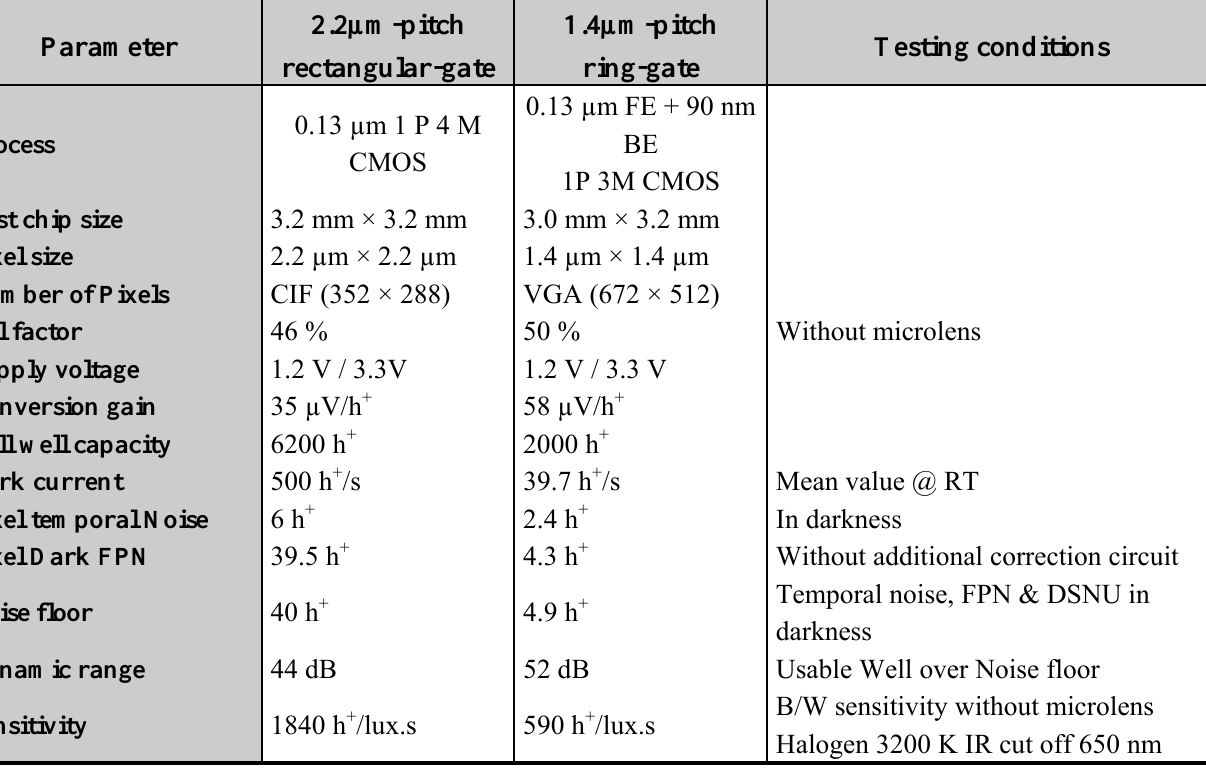
Table 5. Comparison of measured characteristics between the 2.2 µm-pitch rectangular- gate pixel and the 1.4 µm-pitch ring-gate